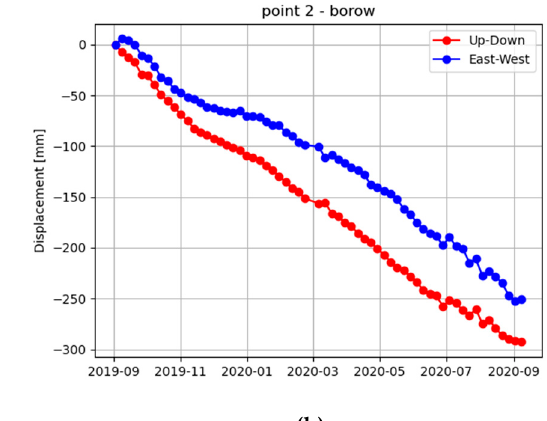
Figure 15. Time series of the extracted Up-Down (red) and East-West (blue) components associated with two points in the deformation area surrounding Borow, as shown in Figure 12.